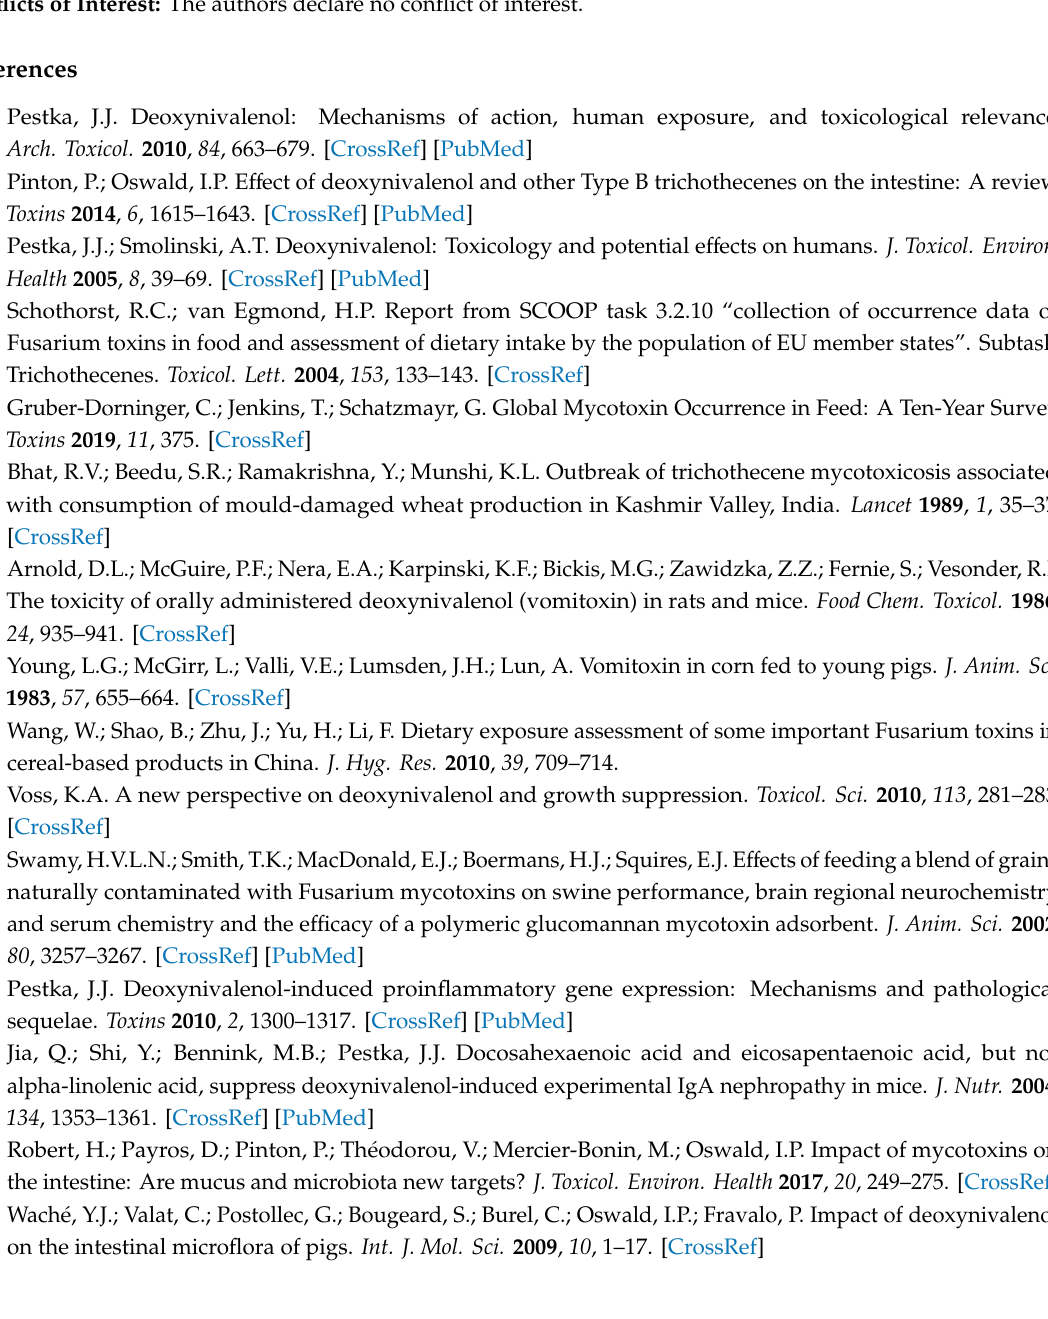
Table S1: Primers used for real-time q-PCR, Figure S1: E ff ects of dietary DON and BCU on serum Biochemical Indexes in